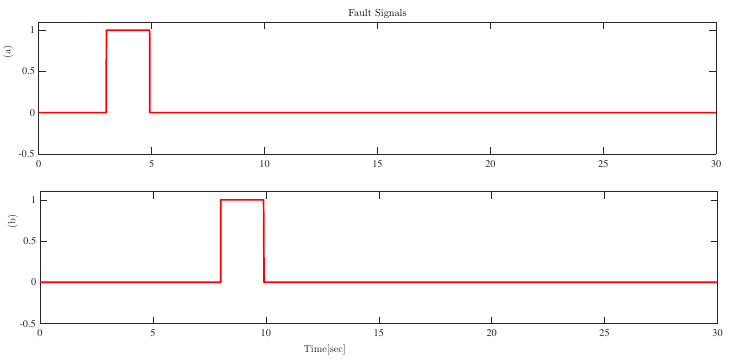
Figure 7 illustrates two sudden faults of pulse generator signals at a phase delay of 3 and 8 s, respectively. It means the first fault is detected at Mode 1, and the second fault is detected at Mode 2, alternatively.